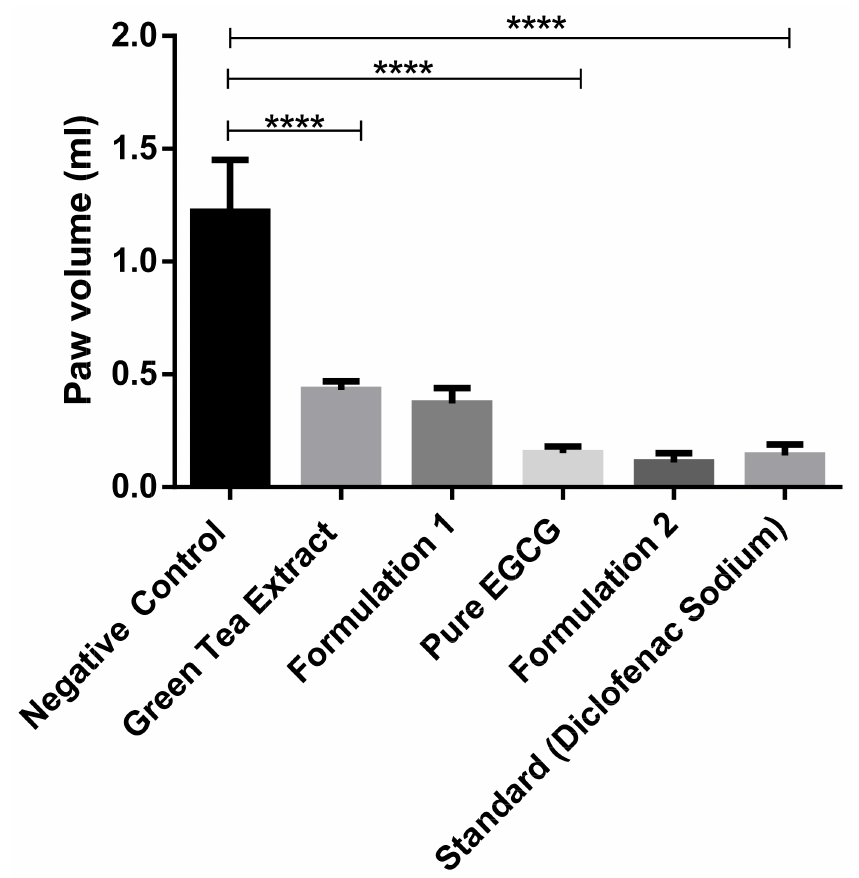
Figure 12. Anti-inflammatory study of green tea extract, pure EGCG and its phytosomal preparations after four days (mean value with 95% CI, where **** means p ≤